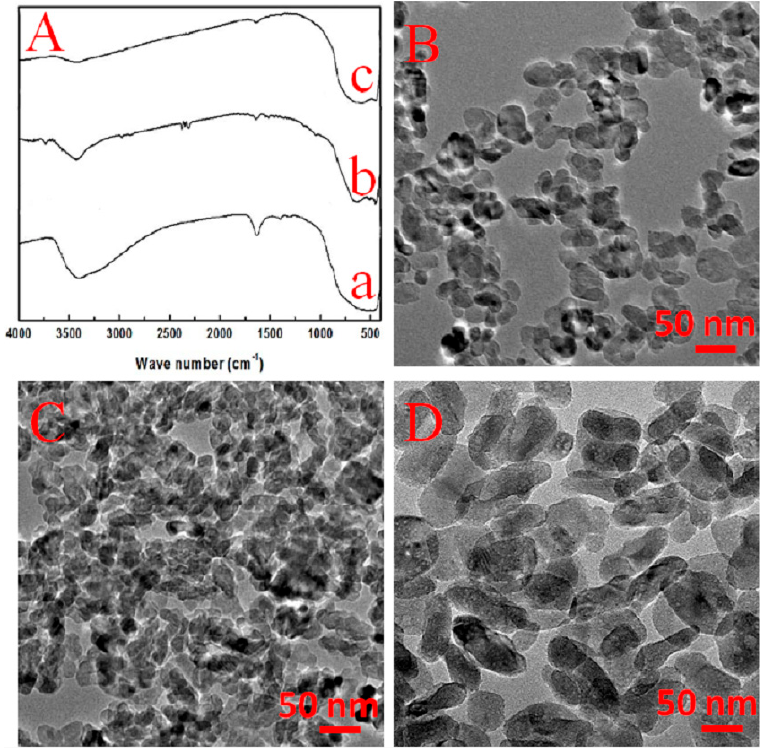
Figure 7. The infrared radiation curves ( A ) for the (a) obtained wet filter cake, (b) dried filter cake, and (c) calcinated filter cake, as well as the TEM images for the ( B ) obtained wet filter cake, ( C ) dried filter cake, and ( D ) calcinated filter